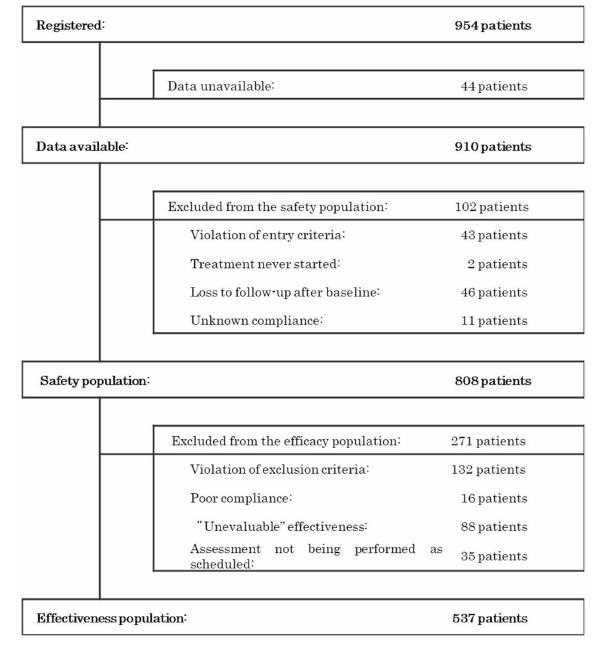
FIGURE 1 | Patient disposition.